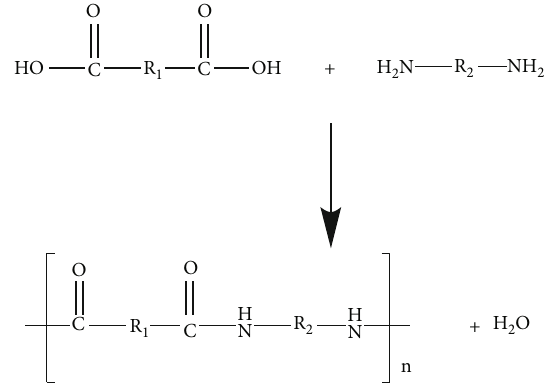
Figure 47: An example of a polyamide